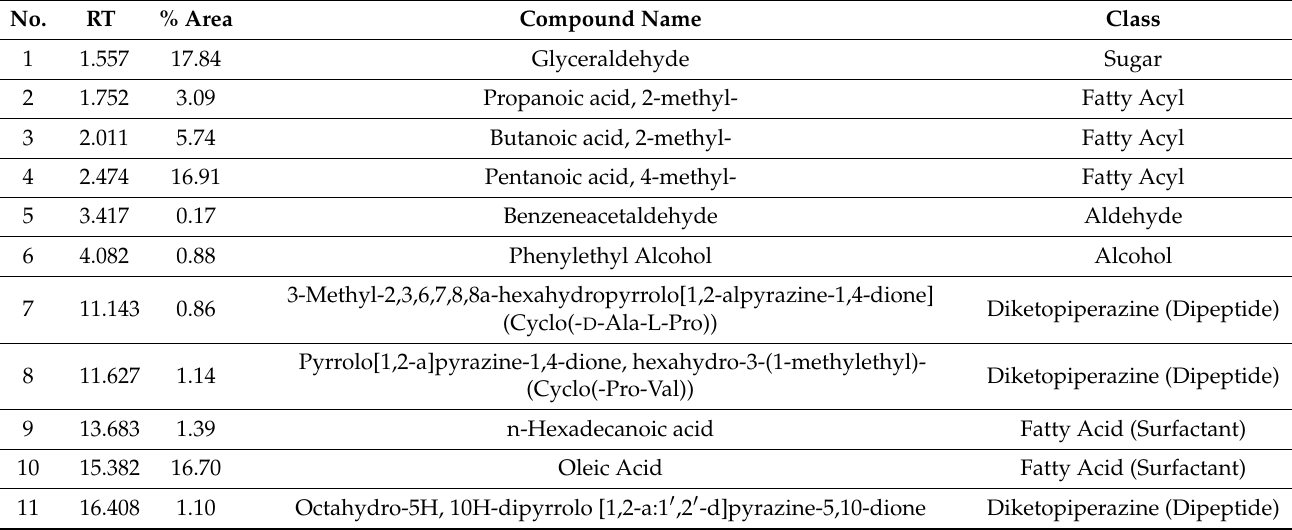
Table 3. Major constituents of the crude biosurfactant of P. pentosaceus using